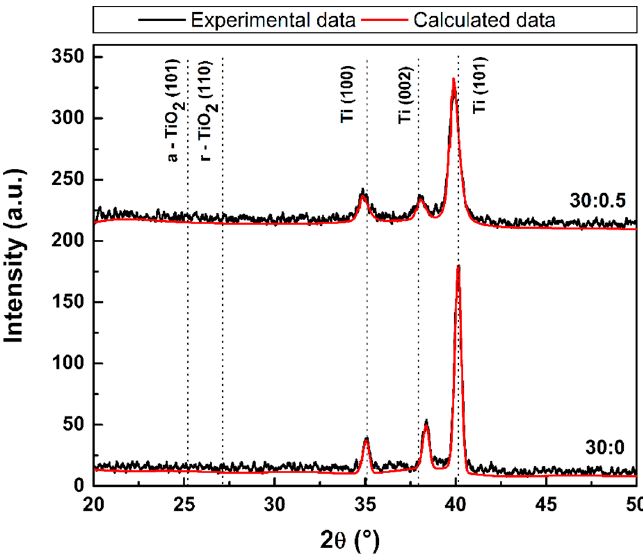
Figure 2. Experimental GI-XRD pattern of a Ti thin film deposited under Ar:O 2 = 30:0 sccm flow rate (bottom) and Ar:O 2 = 30:0.5 sccm flow rate (top) in the chamber (black curves) and simulated patterns (red curves).